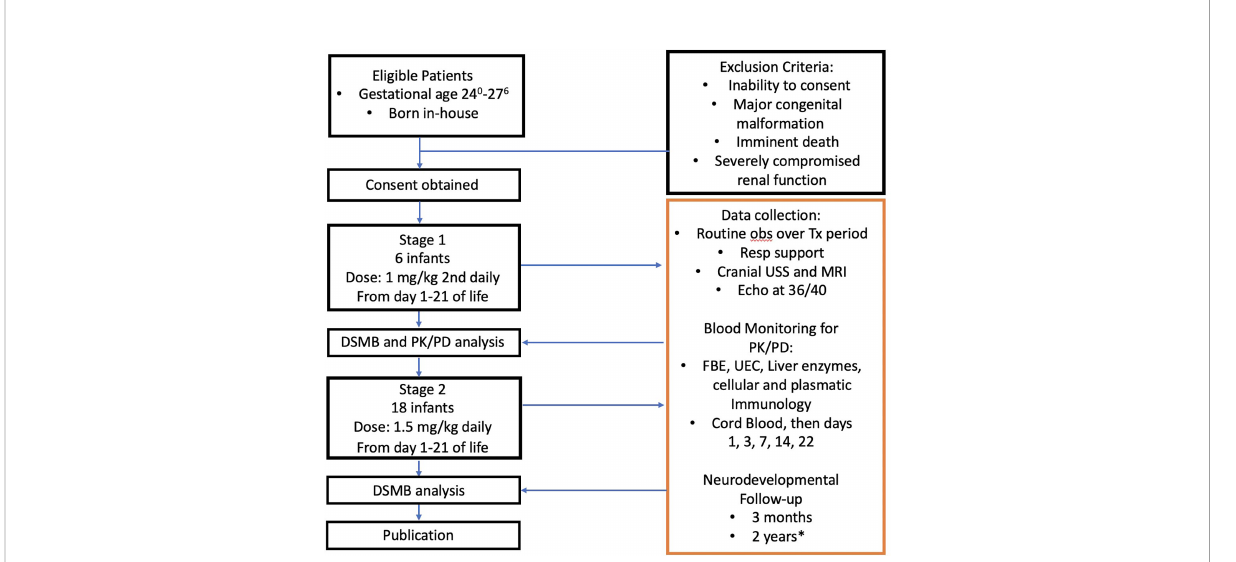
FIGURE 5 Anakinra Pilot fl ow chart. DSMB, Data Safety Monitoring Board; USS, ultrasound study; MRI, magnetic resonance imaging; PK/PD, pharmacokinetic/pharmacodynamic analysis; FBE, full blood examination; UEC, urea, electrolytes, creatinine. *, Publication will not await these result, 2 year follow-up results will be published separately.